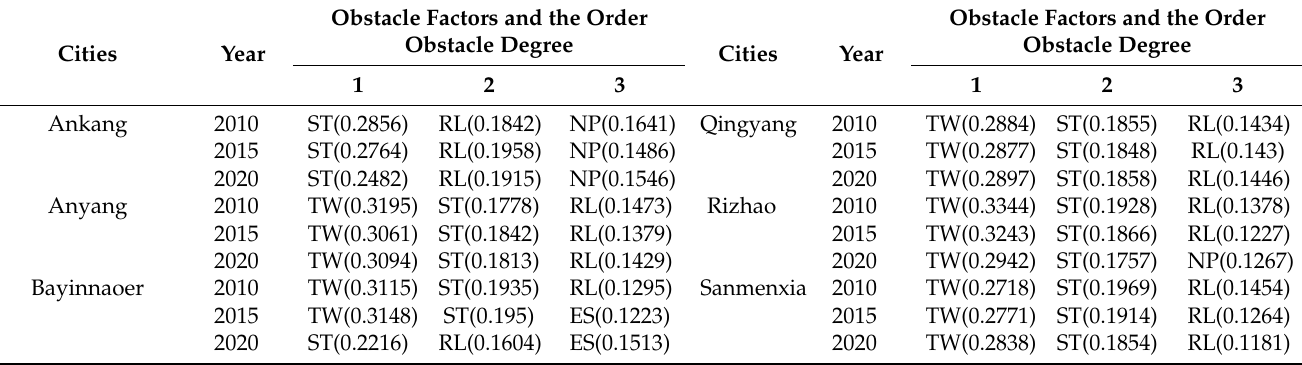
Table A2. Main obstacle elements and order of their degree of impact on the suitability of urban living in the YRB from 2010 to